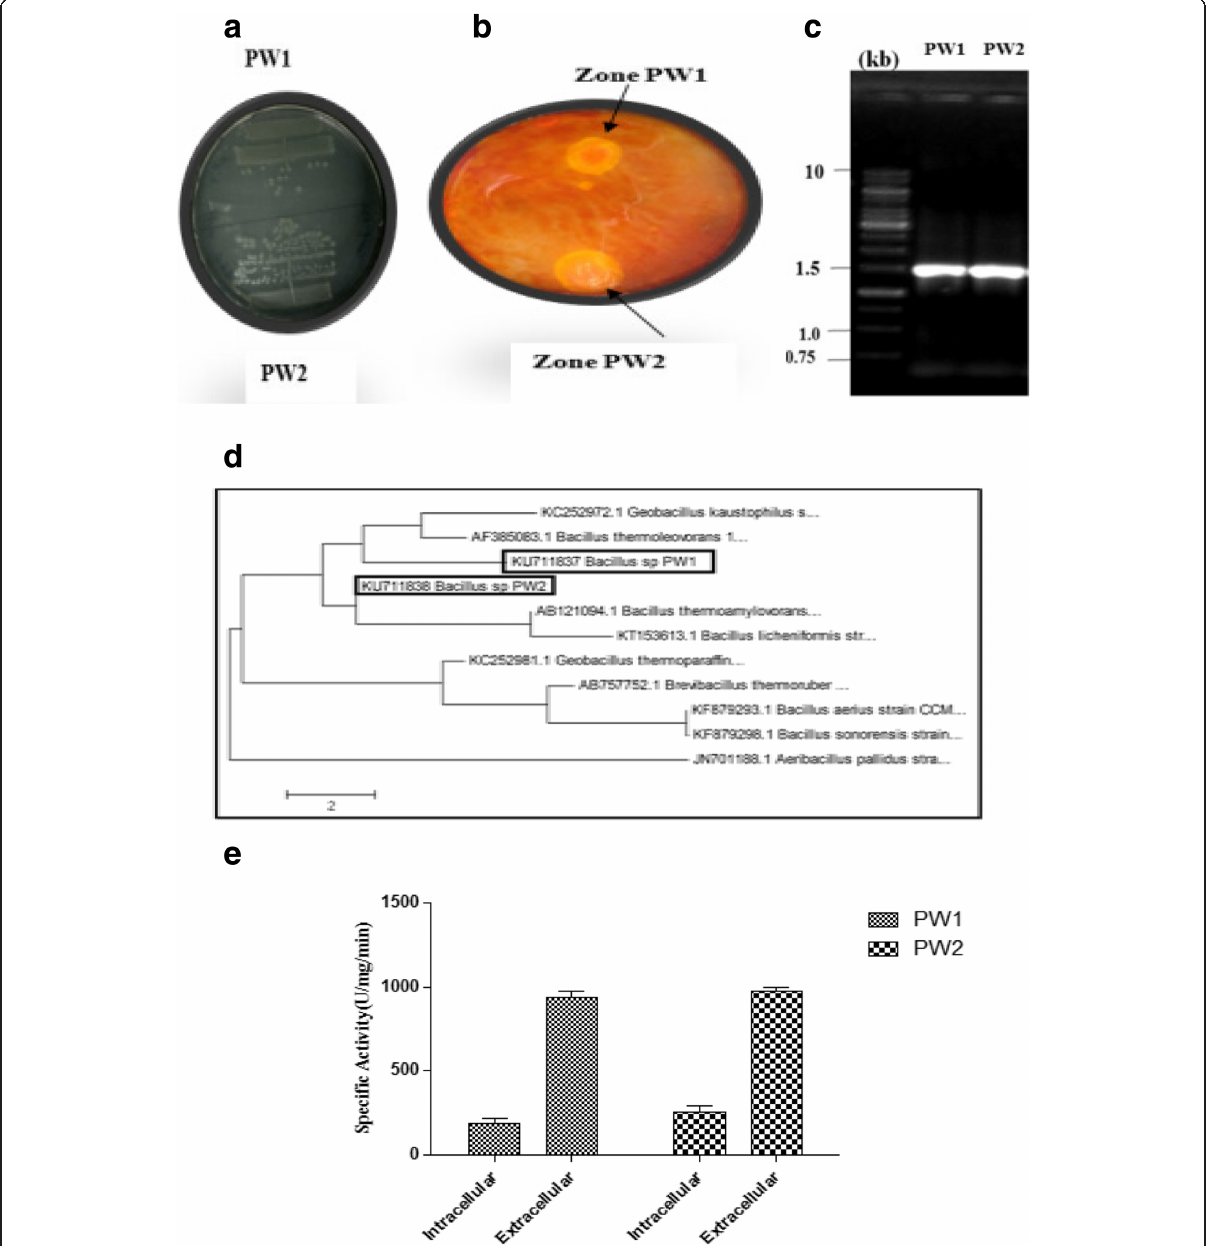
Fig. 1 a Growth of thermophilic bacterial isolates PW1 and PW2 on nutrient agar at 60 °C. b Detection of thermophilic cellulase activity of PW1 and PW2 bacterial isolates. Purified bacterial isolates of PW1 and PW2 were spotted on NA medium supplemented with 1% CMC and incubated at 60 °C for 24 h and flooded with 1% Gram ’ s iodine. The appearance of clear halo zones around bacterial growth indicates cellulase production by PW1 and PW2. c Amplification of 16S rDNA of PW1 and PW2 by PCR. Lanes 1 and 2: PCR products showing 16S rDNA amplification of PW1 and PW2, respectively. The size of 16S rDNA amplicon (~ 1500 bp) is indicated. M size marker (in kb). d Phylogenetic analysis of 16S rDNA sequences of Bacillus sp. PW1 and Bacillus sp. PW2. Dendrogram of PW1 and PW2 with related thermophiles (> 99% homology) is shown. The Jaccard ’ s coefficient scale for genetic relatedness is indicated below phylogenetic tree. e Quantitative cellulase assay of bacterial isolates PW1 and